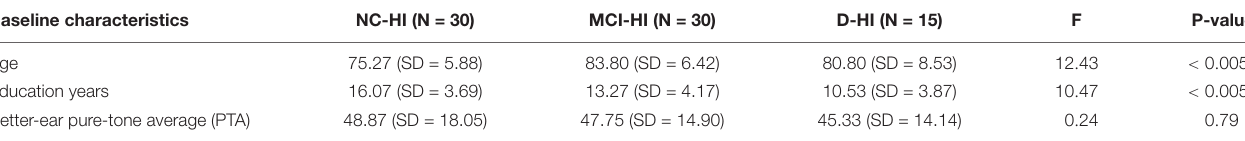
TABLE 1 | Baseline characteristics of the 3